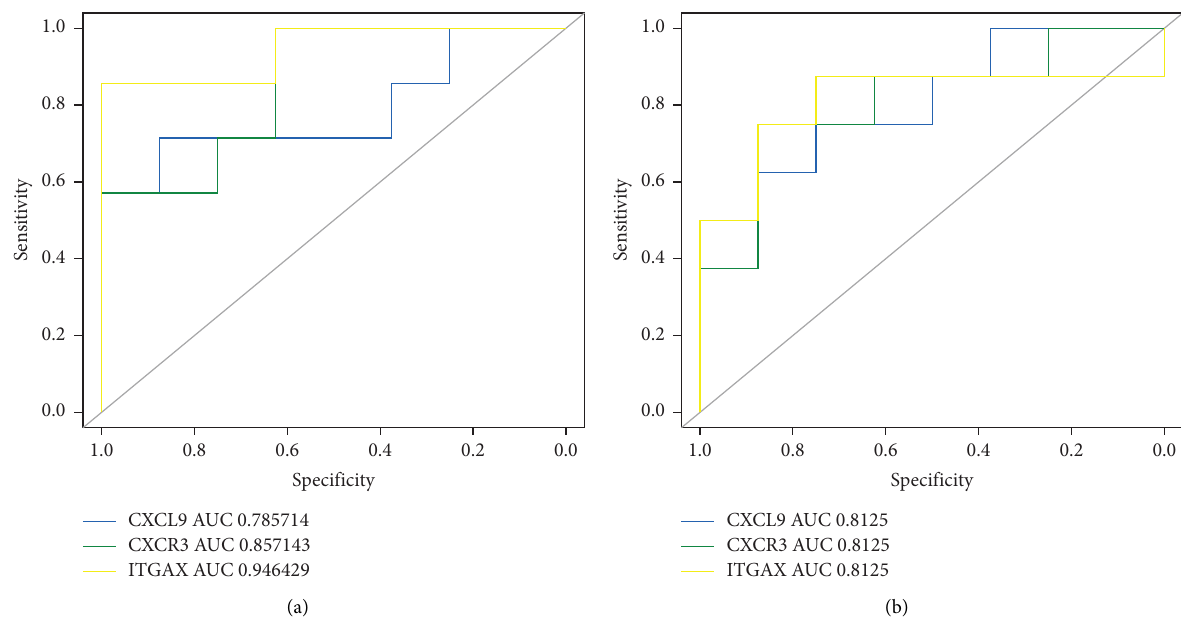
Figure 7: ROC curve of 3 hub genes (CXCL9, CXCR3, and ITGAX) in two datasets. (a) GSE147776. (b)